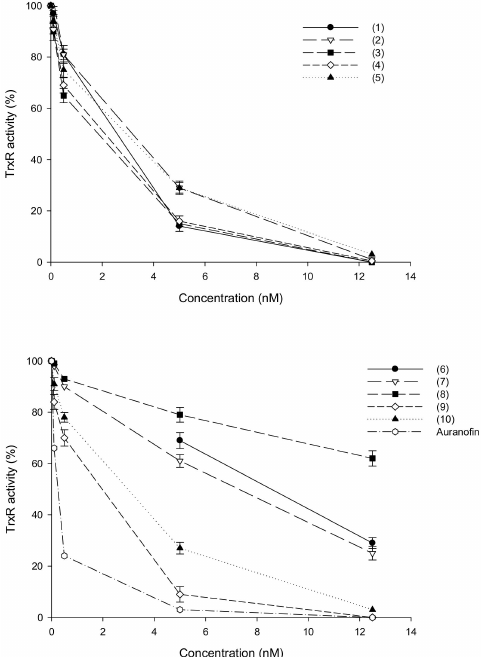
Figure 3. E ff ects of silver(I) complexes on human TrxR1. Thioredoxin reductase 1 activity was assayed by measuring NADPH-dependent reduction of DTNB at 412 nm as described in the Experimental Section. Error bars indicate S.D.